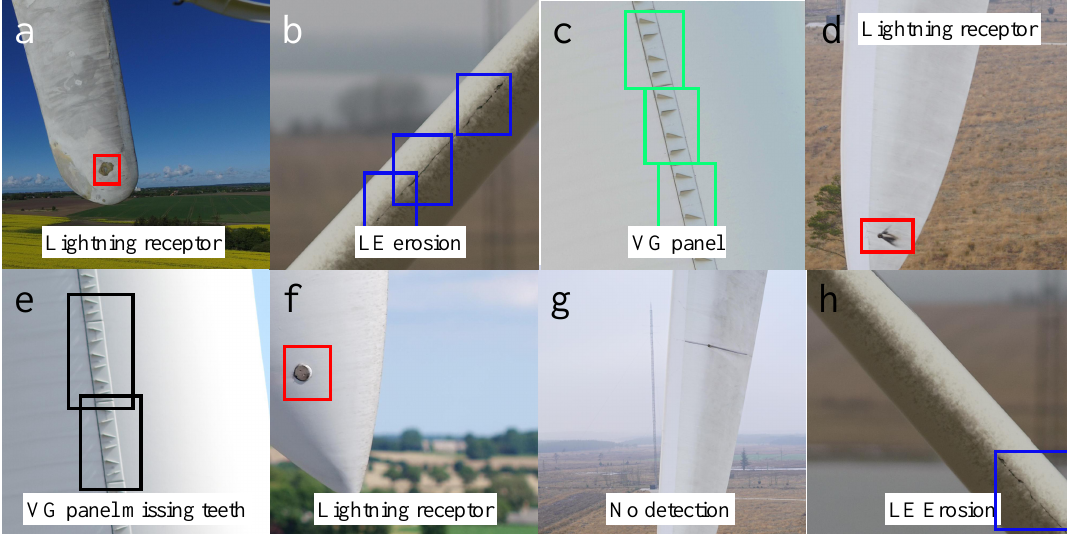
Figure 6. Suggestion results on the test images for the trained model using Inception-ResNet-V2 together with the proposed augmentation